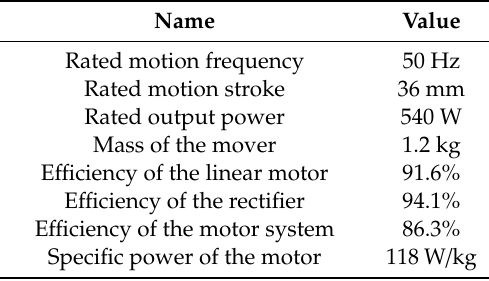
Table 3. Parameters and efficiency of the linear motor system.